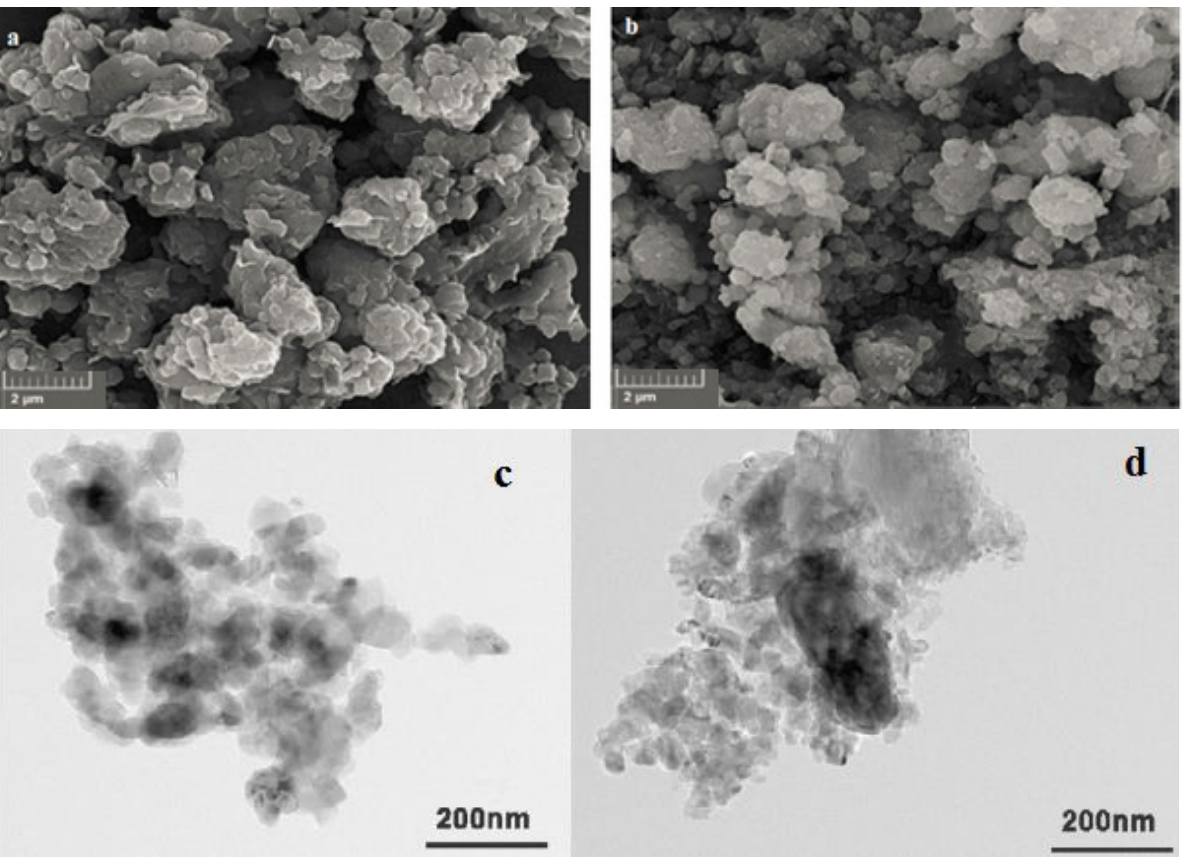
Figure 1. FTIR spectra of bentonite, TiO 2, and Fe 2 O 3 /B/TiO 2 ( a ), Diffuse reflectance UV–Vis spectra ( b ), Tauc plot derived from the Kubelka Munk Function for band gap energy ( c ), Magnetic hystere- sis curves ( d ).